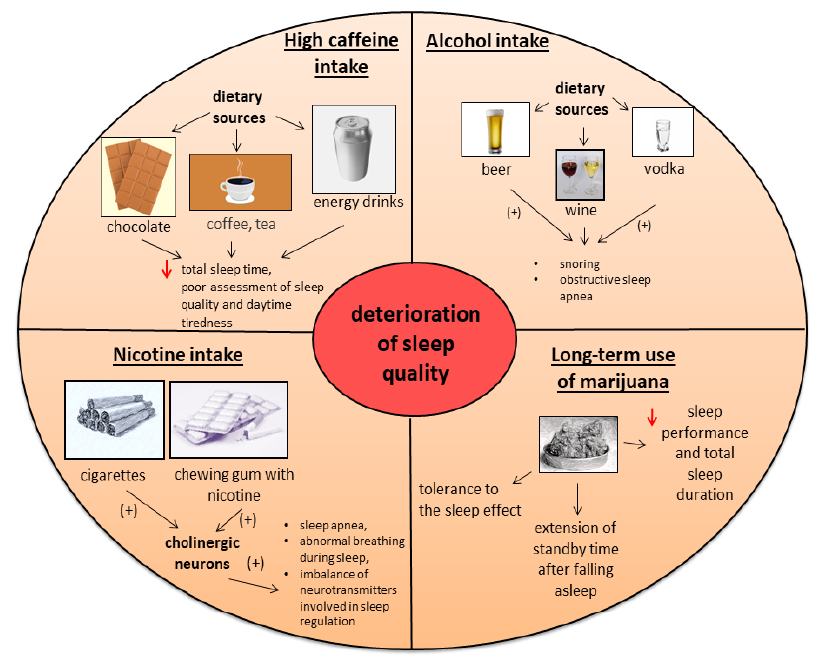
Figure 5. Stimulants and drugs that affect sleep